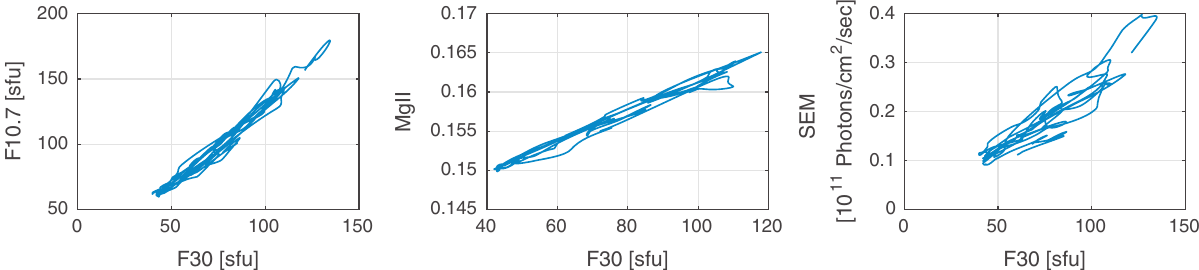
Fig. 4. Scatter plot between the lower envelope of F30 and that of the other proxies. The lower envelope has been averaged over 180 days to ease